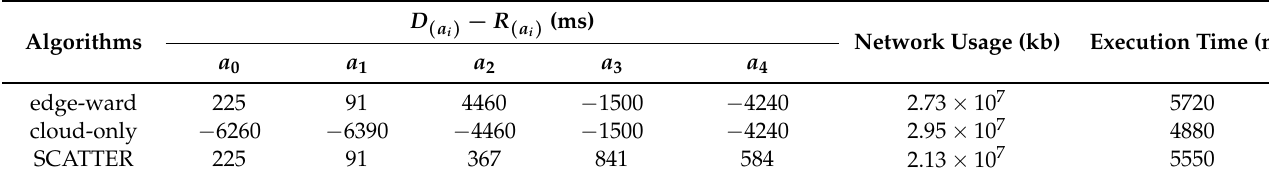
Table 6. Algorithms performance comparison.